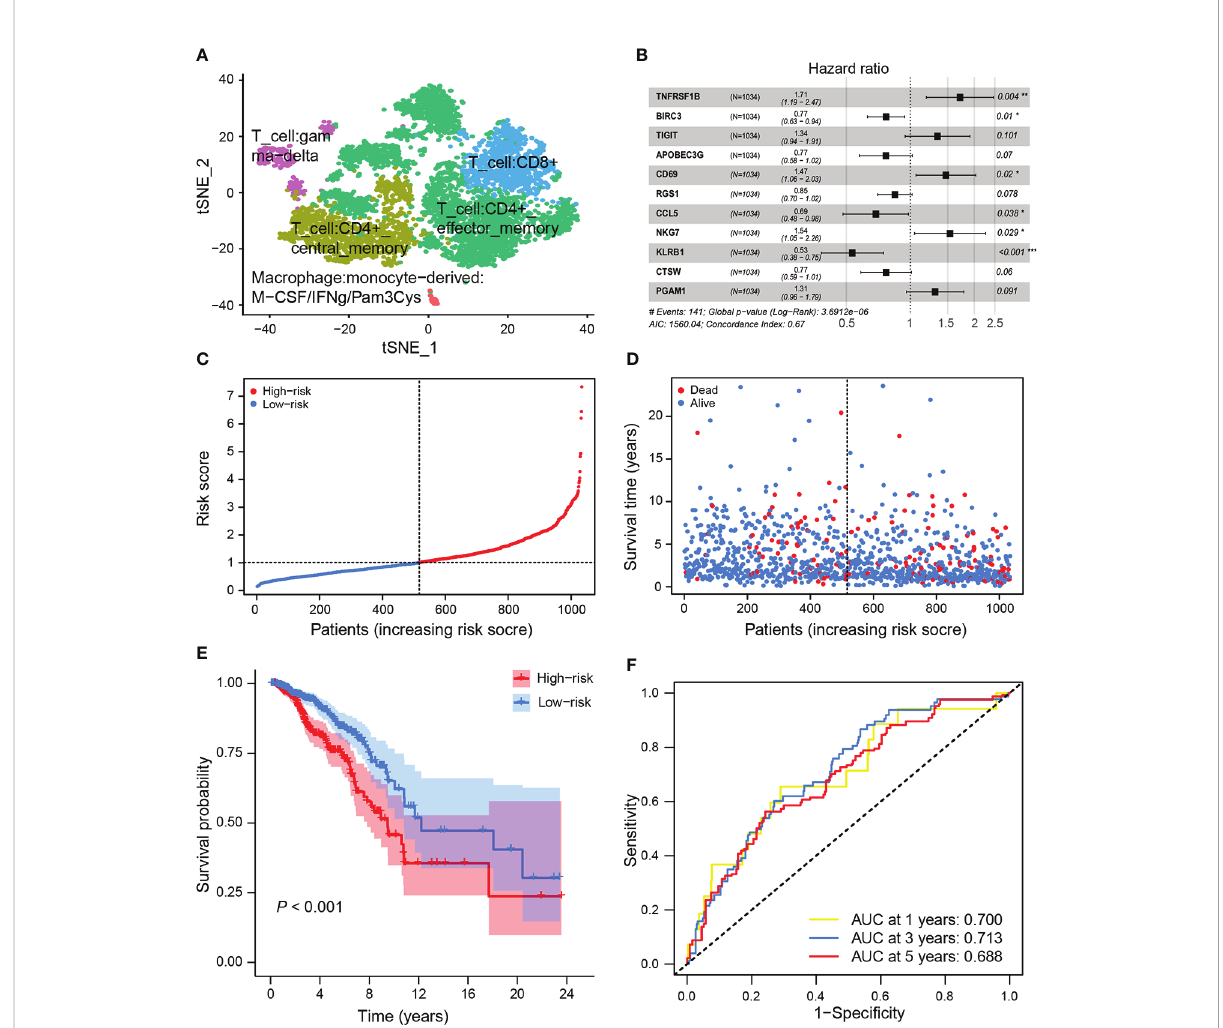
FIGURE 3 Construction of the PTPRO-related CD8 + T-cell signature (PTS) in the training set. (A) t-SNE plot depicted various cell types. (B) The prognostic signature was developed by multivariate analysis of candidate genes that were associated with the overall survival (OS) of breast cancer patients in the training set. (C) Breast cancer patients in the training set were divided into high-risk and low-risk groups based on the median value of the risk score. (D) Breast cancer patients ’ survival status and risk score distribution in the training set. (E) Kaplan – Meier curve analysis of OS between the high-risk and low-risk groups in the training set. (F) ROC curves of the risk score to predict the 1-, 3-, and 5-year OS in the training